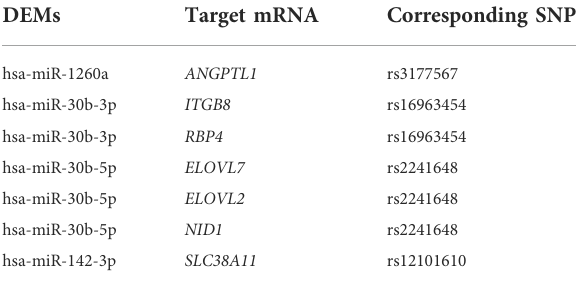
TABLE 2 Target mRNAs of DEMs in the mRNA-SNP-miRNA